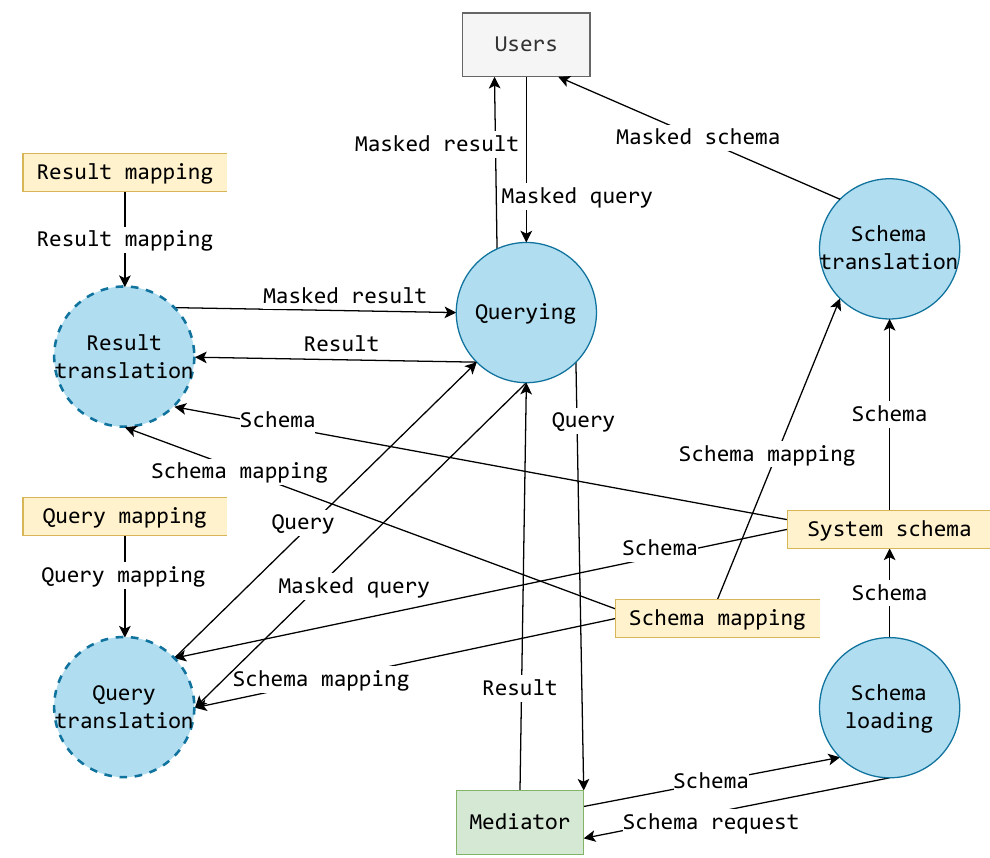
Figure 11. Dataflow diagram following the mask’s